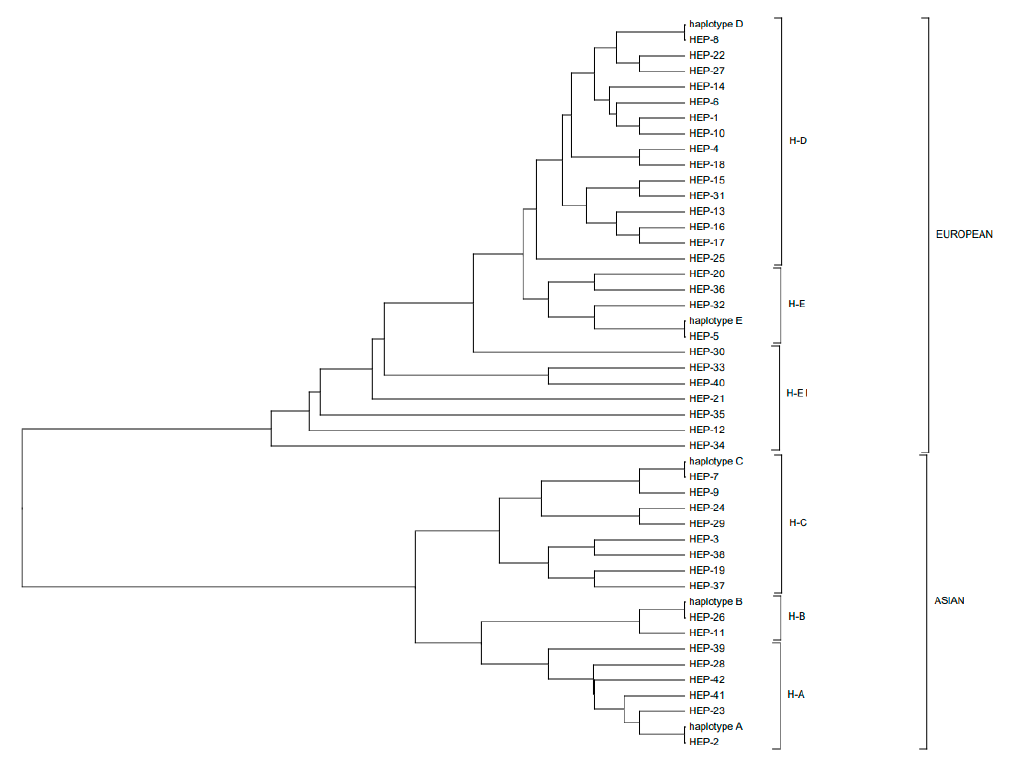
Figure 2. Distribution of haplotypes relative to haplogroups A, B, C, D, E.